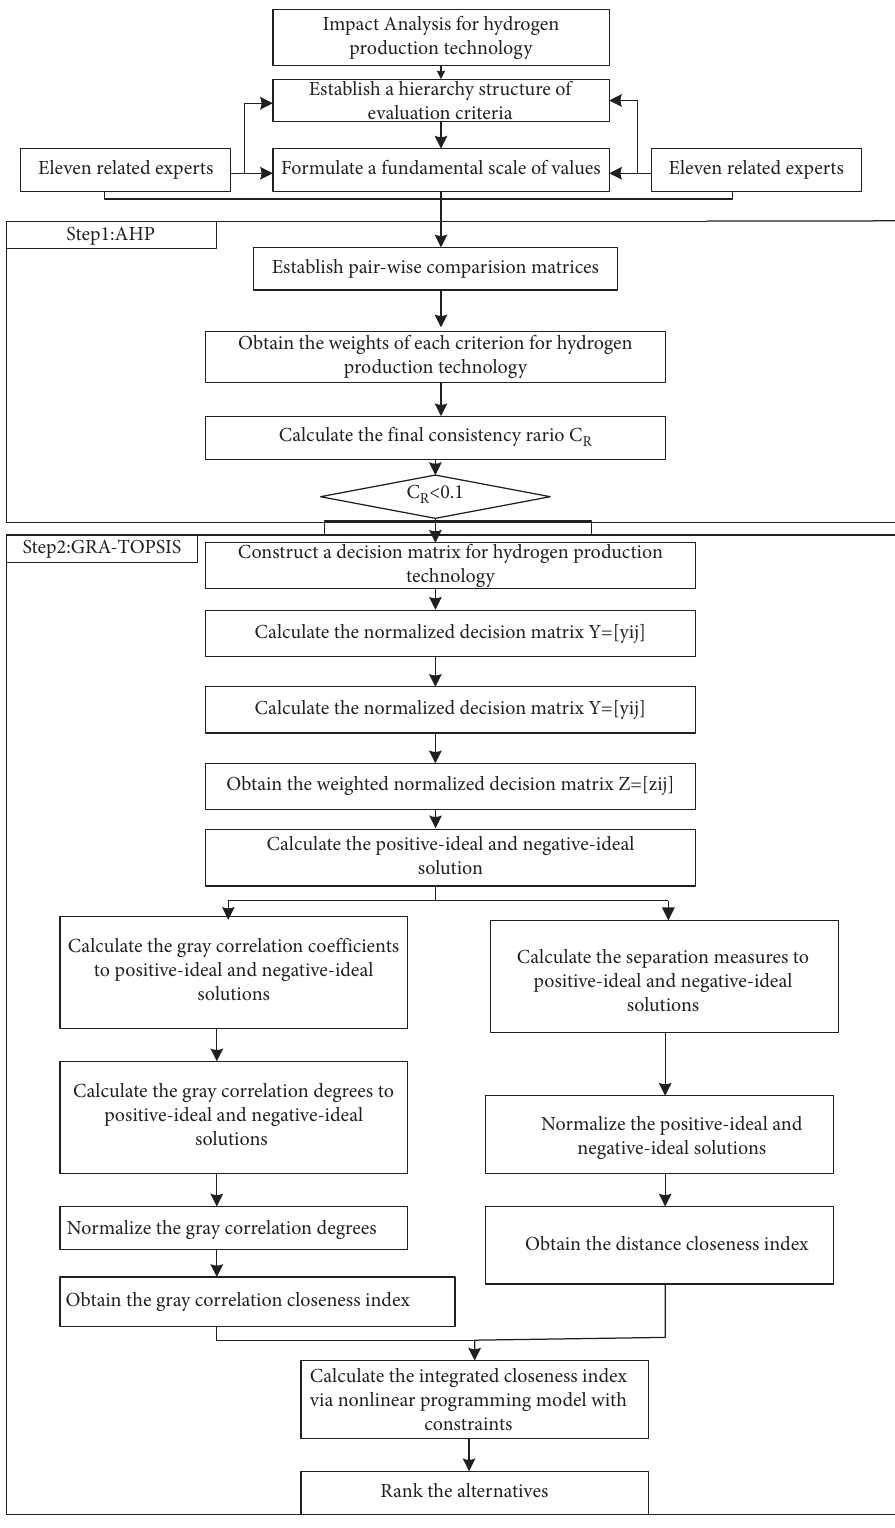
Figure 1: Model frame